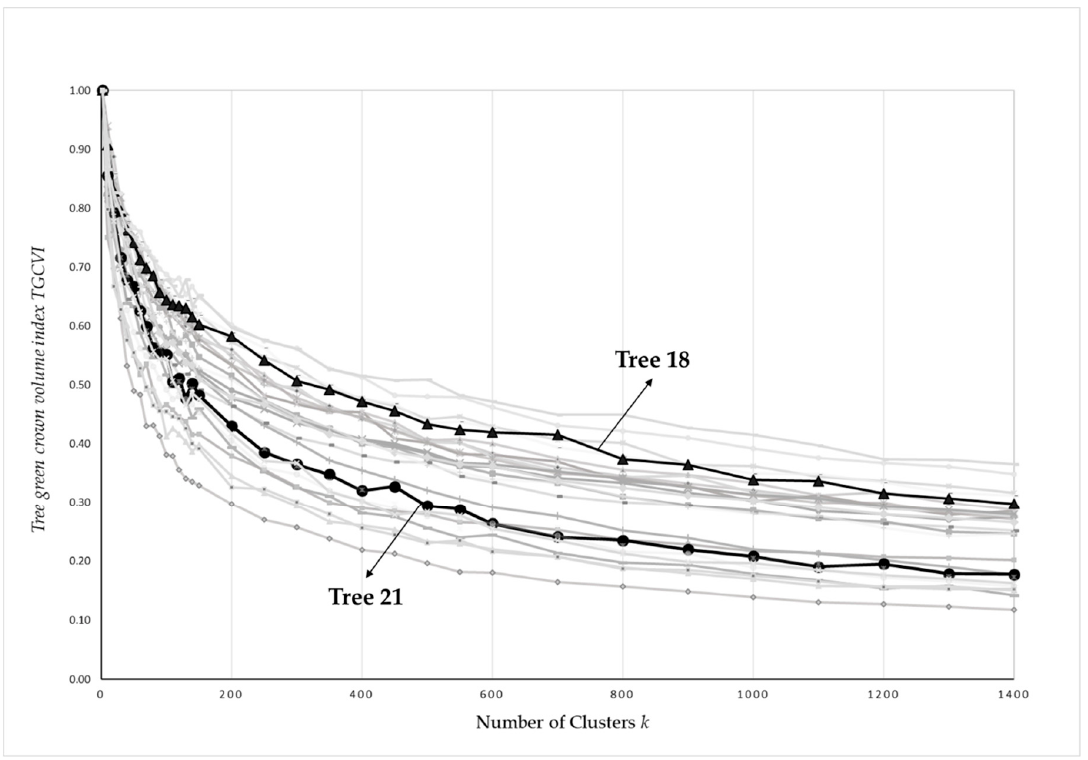
Figure 7. Tree green crown volume index (TGCVI) over number of clusters k . As to be expected: the more clusters are formed, the finer is the separation of green and empty spaces within the crown which leads to decreasing values of TGCVI . The y -axis is the normalized TGCVI . Tree 21 and Tree 18 are highlighted by the bold line with markers. Table 3. The sample trees and their tree green crown volume index.